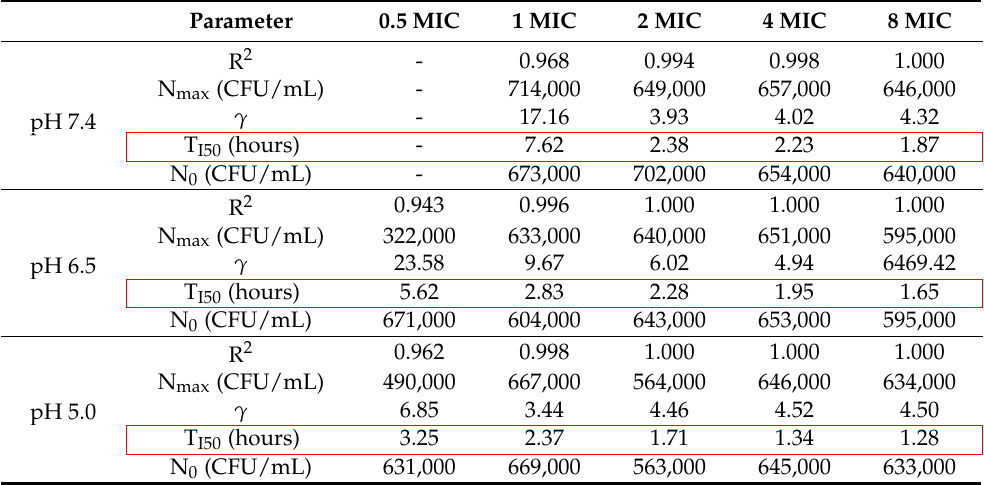
Table 7. Mean of the parameters estimated by the sigmoid minus the base model for the wild-type strains at pH 7.4, 6.5, and 5.0.